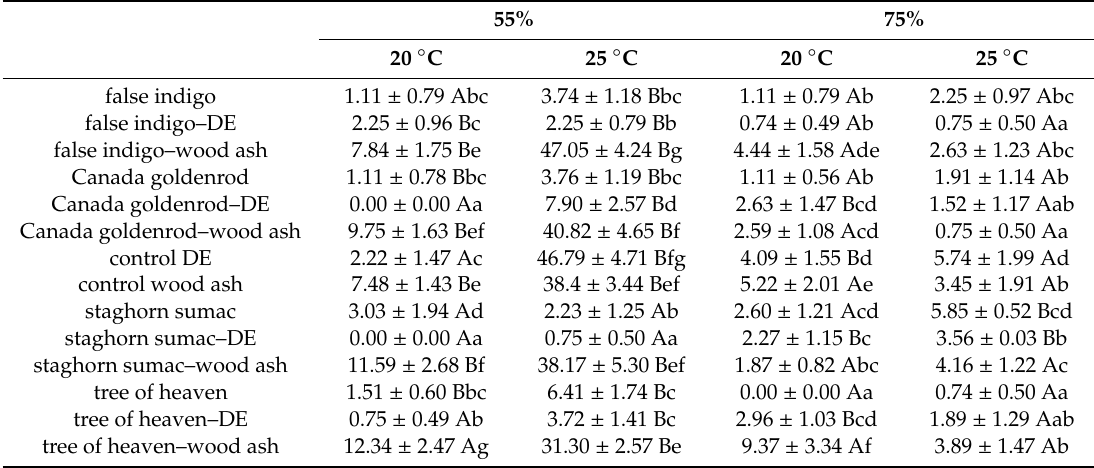
Table 6. Mean mortality (% ± SE) of Sitophilus oryzae exposed to di ff erent treatments for 7